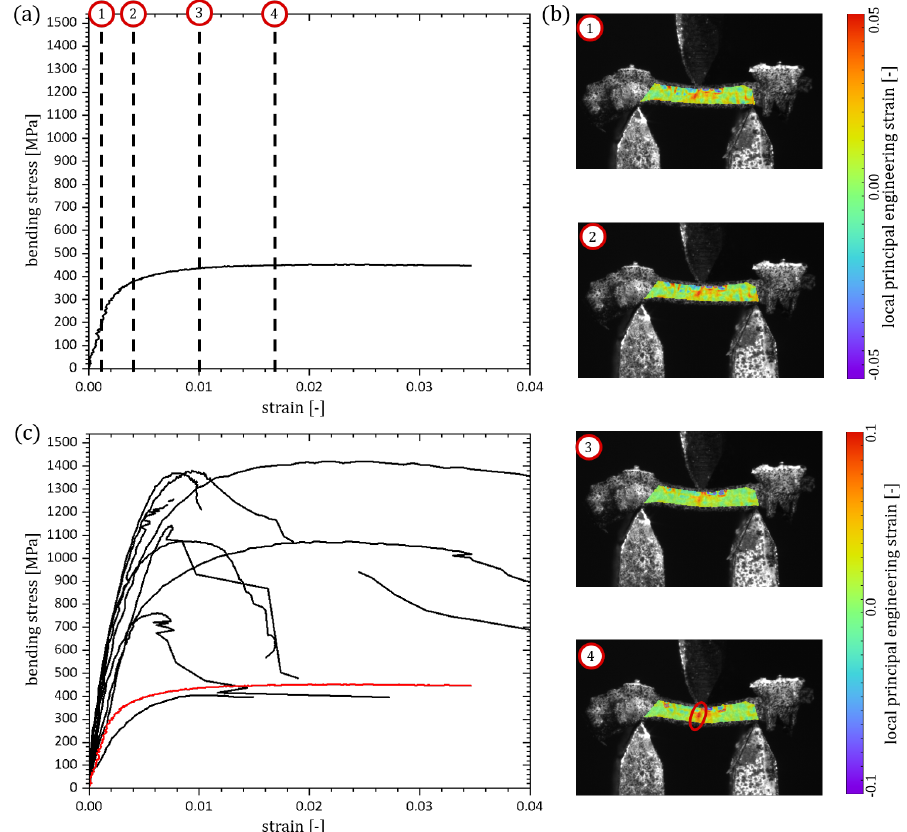
Figure 7. Results of 10 bending tests on Ni/PU hybrid foam struts: ( a ) exemplary bending stress-strain-diagram with four marked positions, ( b ) DIC results for the four marked positions in ( a ), with the crack highlighted (red ellipse) in the last step, ( c ) stress-strain-diagrams for all 10 struts, with the exemplary strut highlighted in